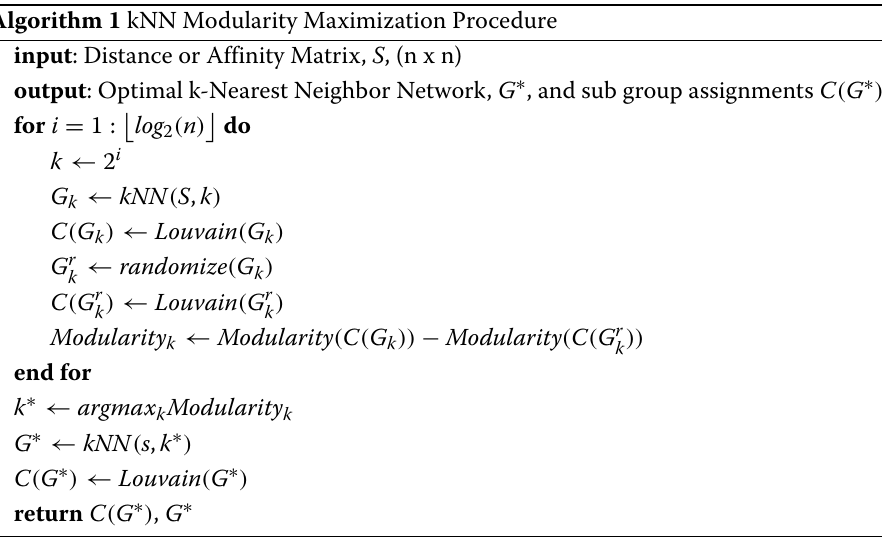
Algorithm 1 kNN Modularity Maximization